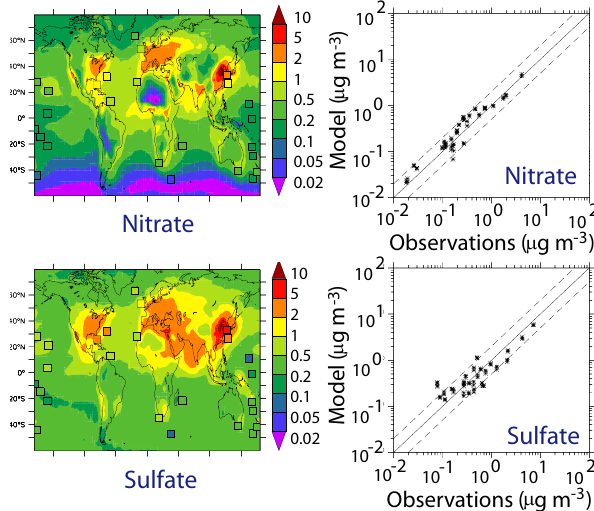
Fig. 14. Comparison of modelled data to data collected by AE- ROCE. Maps show surface concentrations of nitrate (top) and sul- fate (bottom) for the year 2002 simulated using ISORROPIA-II with observed values overplotted (squares). Scatter plots show the comparison of modelled vales to AEROCE data for nitrate (top) and sulfate (bottom) for the year 2001 (triangles) and 2002 (stars). All units are µgm − 3